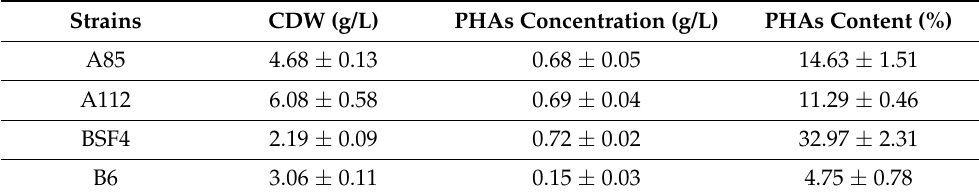
Figure 1. The fluorescence microscope examination of endogenous PHA-accumulating strains Halo- arcula hispanica A85 ( A ), Natrinema altunense A112 ( B ), Halomonas salina BSF4 ( C ), and Halomonas janggokensis B6 ( D ) stained with Nile red. The Nile red-stained PHA-defeated strain Haloferax medi- terranei ΔEC was used as a negative control to preliminarily determine the accumulation of PHAs observed under fluorescence ( E ) and bright field ( F ). Table 2. The PHA accumulation quantified by gas chromatography.